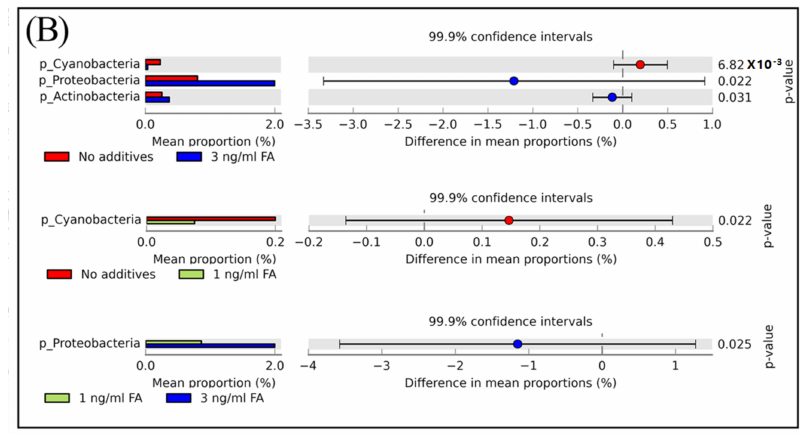
Figure 3. The relative abundance of bacterial community composition at the phylum level ( A ) and different phyla between untreated and FA treated mice detected by STAMP software [41] ( B ). In Panel ( A ) error bars are illustrated as standard deviations. In Panel ( B ) comparisons of the relative abundance of bacterial community composition were made between the 3 ng/mL FA group and the untreated group ( top ), between the 1 ng/mL FA group and the untreated group ( middle ), and between the 1 ng/mL group and the 3 ng/mL group ( bottom ). For each comparison, the mean proportion of phyla ( left ) and difference in mean proportions ( right ) were